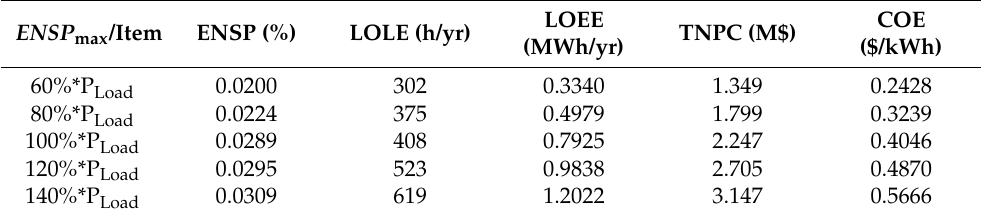
Table 13. Reliability and cost results in sizing the HPV/FC energy system using the IAEO and ENSP max = 5% considering load variations.